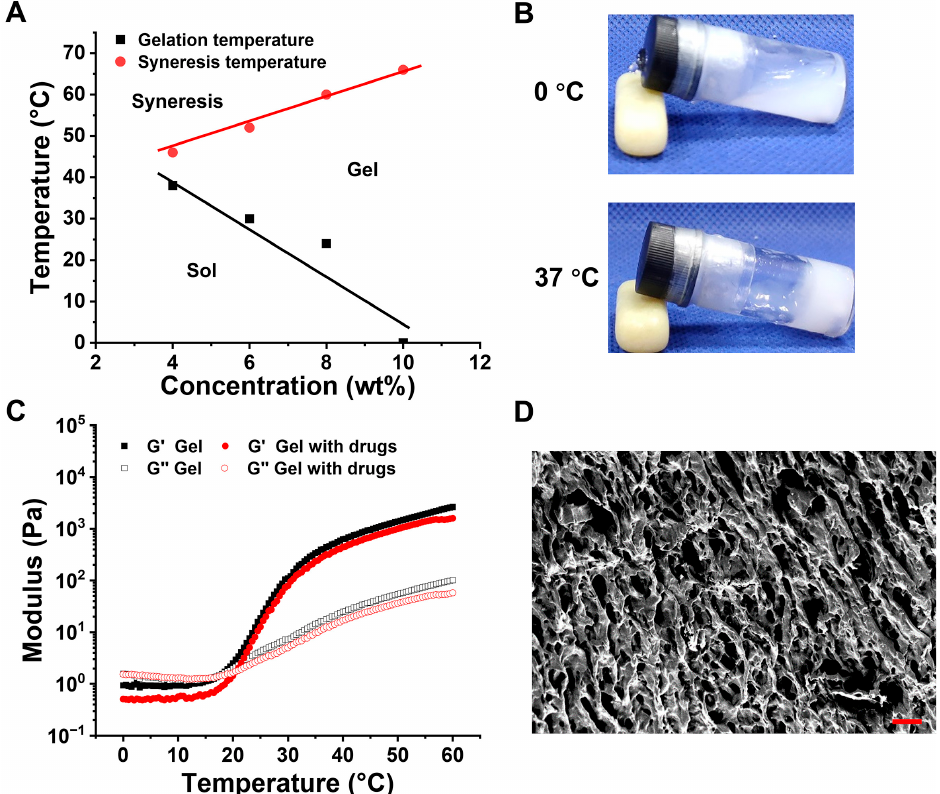
Figure 1. ( A ) Temperature-dependent sol–gel phase diagram of mPEG-PELG hydrogel. ( B ) Photo- tographs of 6 wt% mPEG-PELG solution in PBS at 0 ◦ C and the hydrogel formation at 37 ◦ C. graphs of 6 wt% mPEG-PELG solution in PBS at 0 °C and the hydrogel formation at 37 °C. ( C ) Tem- perature-dependent variations in the storage modulus (G ′ ) and loss modulus (G ″ ) of the 6 wt% blank ( C ) Temperature-dependent variations in the storage modulus (G (cid:48) ) and loss modulus (G (cid:48)(cid:48) ) of the mPEG-PELG hydrogel or Dox/IgG-loaded hydrogel (Dox: 1 mg/mL; IgG: 1 mg/mL). ( D ) SEM image 6 wt% blank mPEG-PELG hydrogel or Dox/IgG-loaded hydrogel (Dox: 1 mg/mL; IgG: 1 mg/mL). of lyophilized mPEG-PELG hydrogel (6 wt%). Scale bar = 20 μ m. ( D ) SEM image of lyophilized mPEG-PELG hydrogel (6 wt%). Scale bar = 20 µ